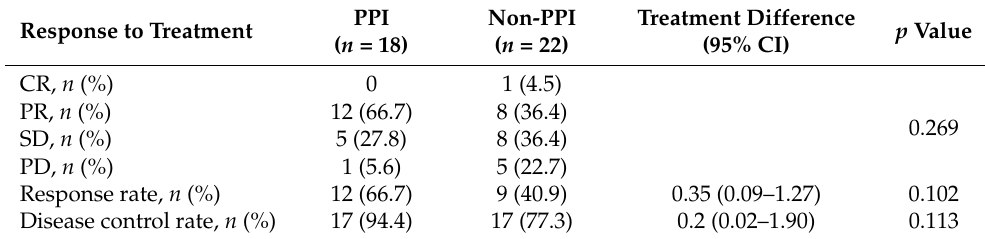
Table 2. Clinical outcomes of esophageal cancer patients in the PPI and non-PPI groups. Response to